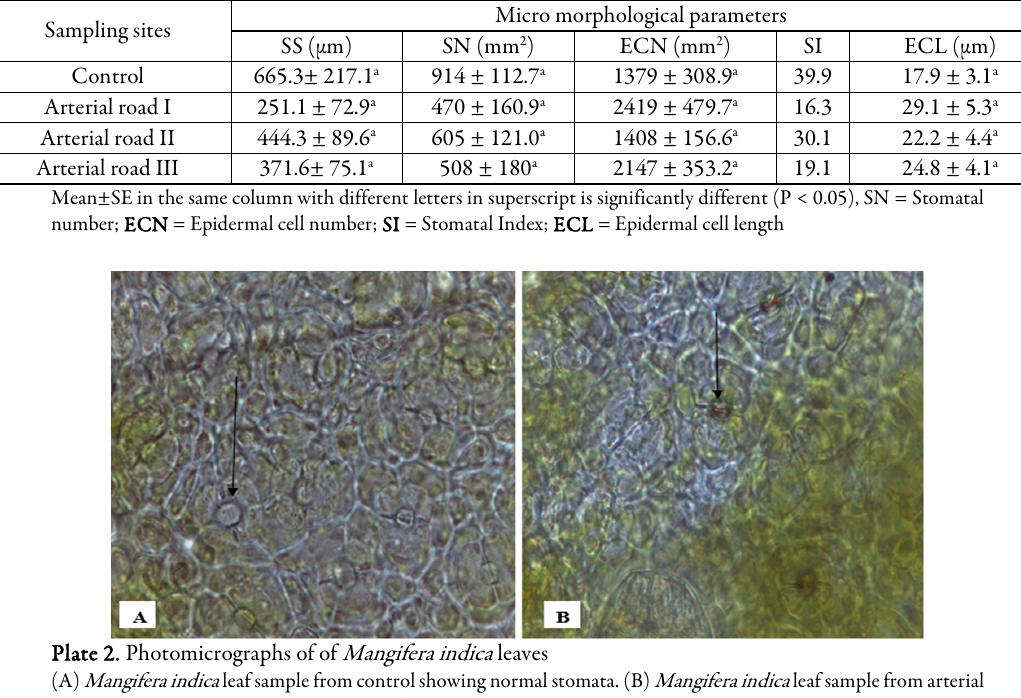
Table 6. Effect of vehicular pollution on micro-morphological variations of Mangifera indica leaves at the study sites in Kumasi Metropolis